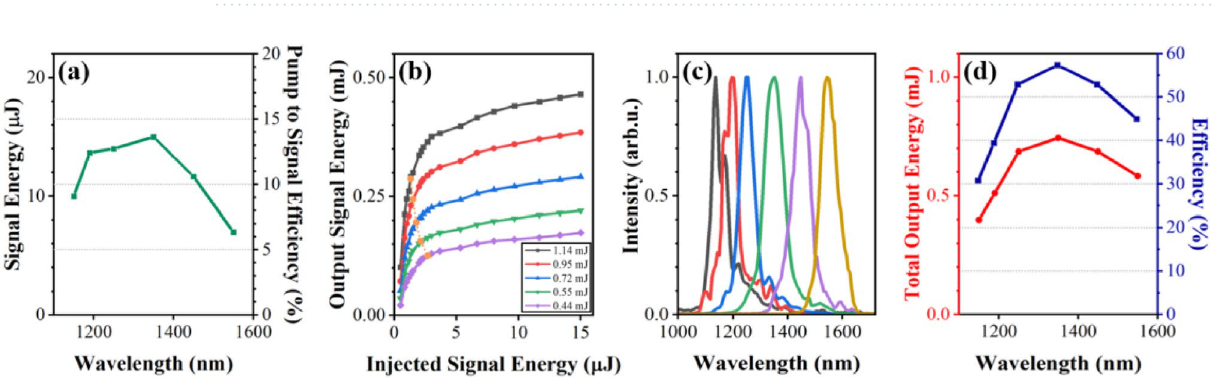
Figure 2. ( a ) Energy of signal pulse (left axis) in the pre-amplifier along with the internal conversion efficiency (right axis). ( b ) Output signal energy as a function of the input signal and pump energy in the power amplifier. ( c ) Spectra of output signals at different wavelengths. ( d ) The total output energy (signal plus idler pulse) (red dots) and the corresponding conversion efficiency (blue squares) for a total pump energy of 1.3